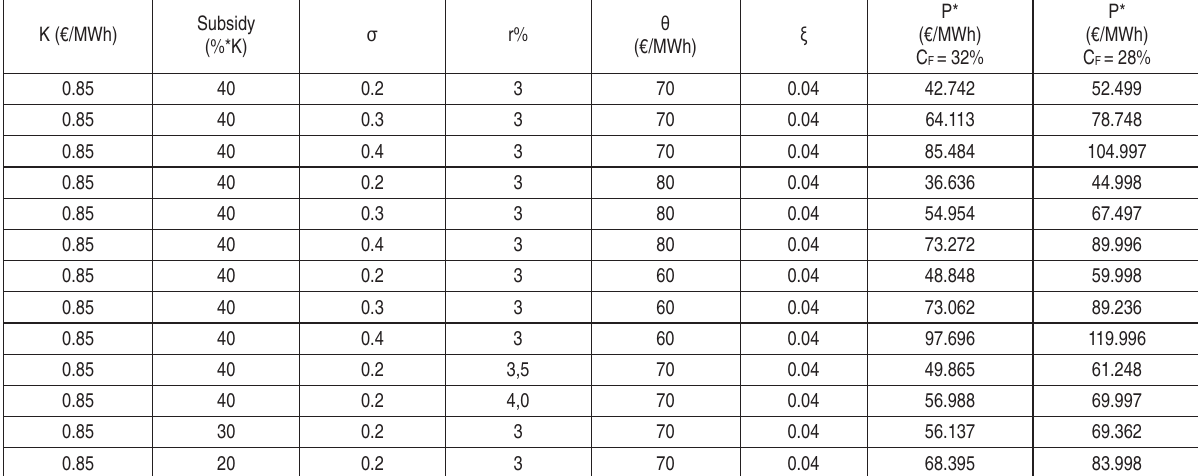
Table 3. Investment